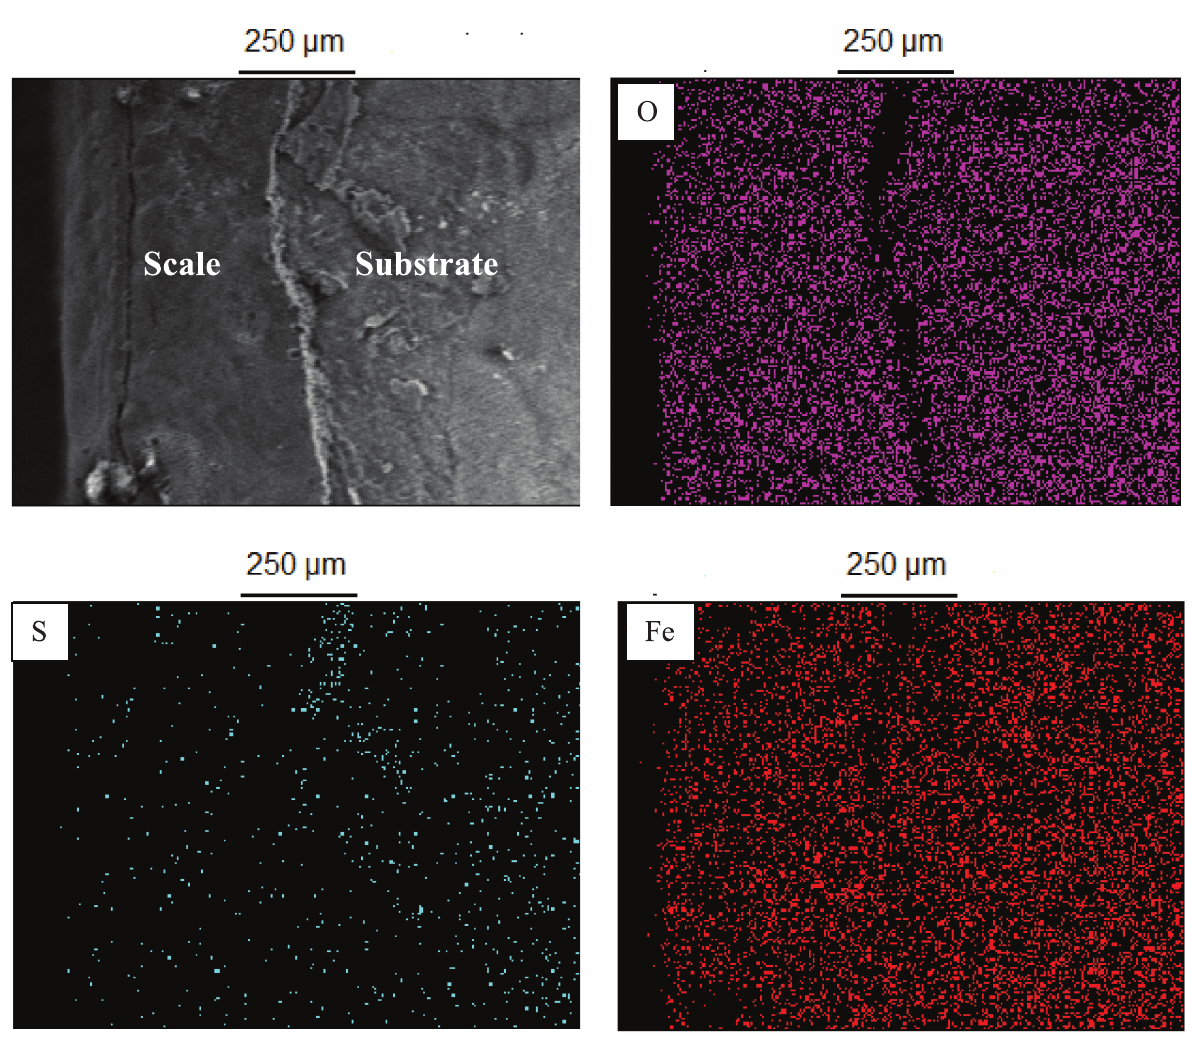
Fig. 7: X ray mapping analysis of oxygen (O), sulfur (S) and iron (Fe) of the scale and substrate of 50.4% deformed